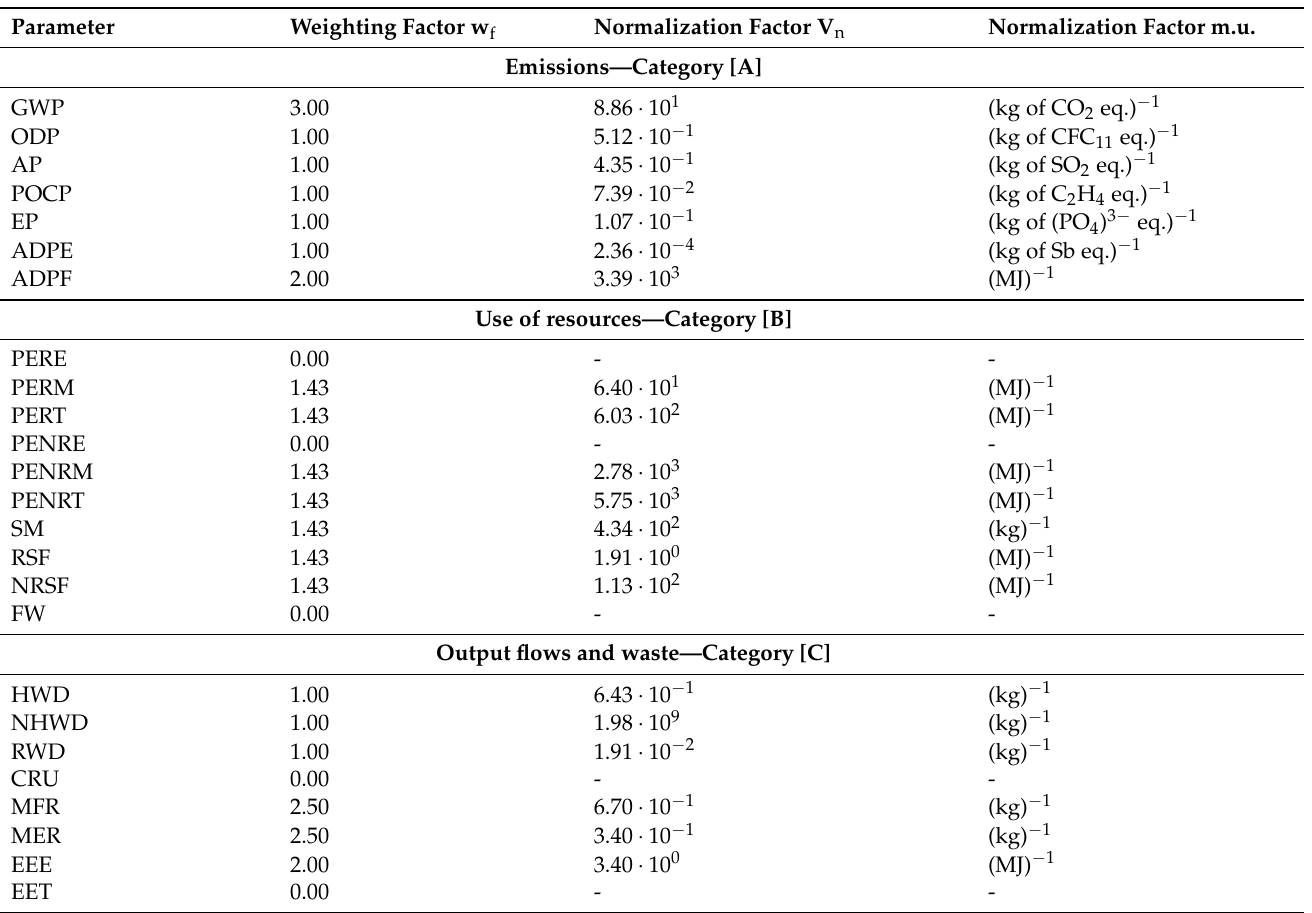
Table 7. Selected values for weighting and normalization